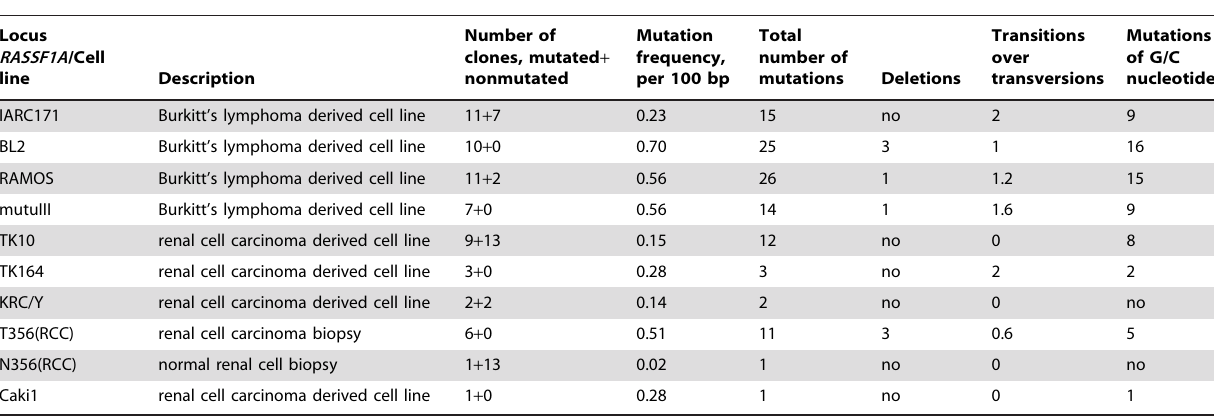
Table 2. Mutations in RASSF1A exon 1and 2 in different cell types.